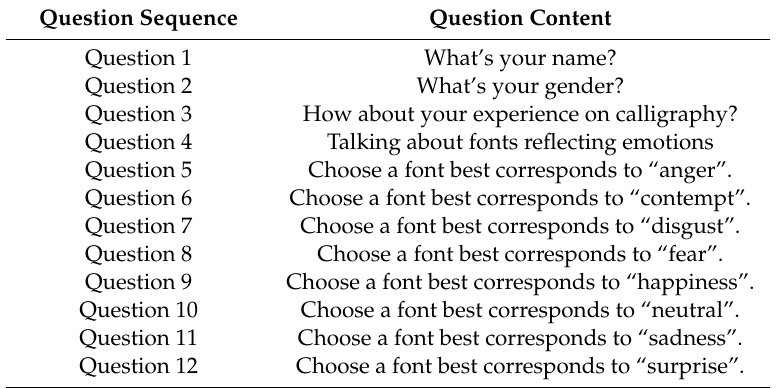
Table 1. Questions 1–4 aim to acquire basic information of respondents, which is useful to improve the credibility of questionnaire. Questions 5–12 are main content of questionnaire.